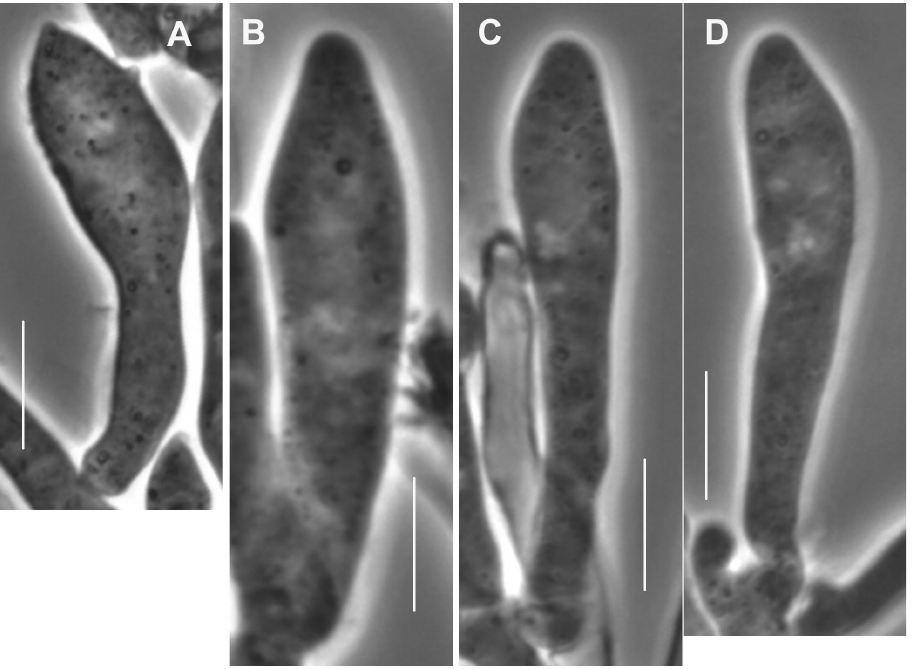
Figure 81. Mycetinis scorodonius f. diminutivus . Pleurocystidia. Standard bars = 10 µm. WTU 10961-